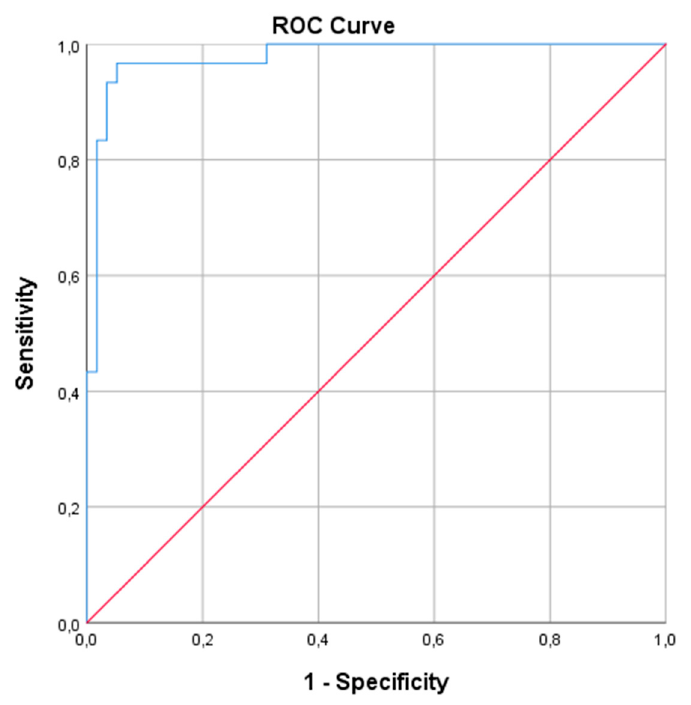
Figure 2. ROC curve analysis of the utility of CA IX to severe OSA. The red line is the reference and the blue line is the ROC curve.